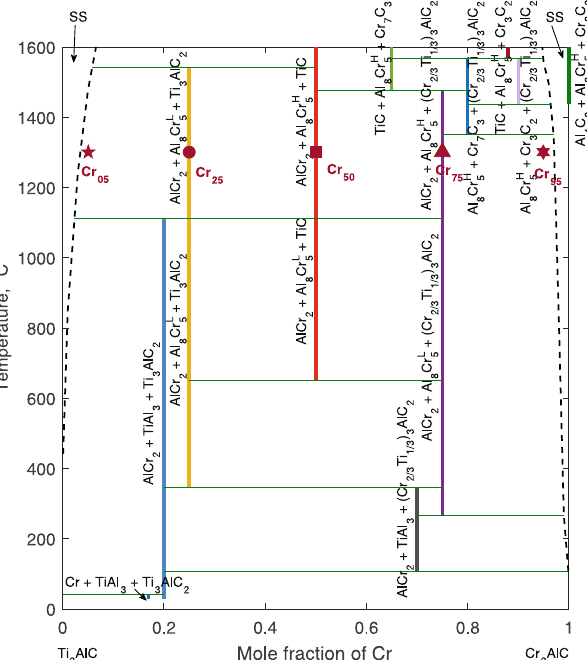
Figure 2. Deterministic phase diagram of Ti 2 AlC-Cr 2 AlC. Note that above 1410 °C Cr 2 AlC tends to decompose into Al 4 C 3 , Al 8 Cr 5 , and Cr 3 C 2 , as according to the current deterministic evaluation. Here, the symbols indicate experimental data from Horlait et al . 20 : Cr 05 : Al 2 Cr + TiAl 2 + (Cr 0.02 Ti 0.98 ) 2 AlC + (Cr 0.02 Ti 0.98 ) 3 AlC 2 ; Cr 25 : AlCr 2 + Al 8 Cr 5 + TiC + (Cr 0.02 Ti 0.98 ) 3 AlC 2 ; Cr 50 : AlCr 2 + Al 8 Cr 5 + TiC + (Cr 0.95 Ti 0.05 ) 2 AlC; Cr 75 : AlCr 2 + Al 8 Cr 5 + TiC + (Cr 2/3 Ti 1/3 ) 3 AlC 2 ; Cr 95 : Al 80 Cr 20 + TiC + (Cr 0.95 Ti 0.05 ) 2